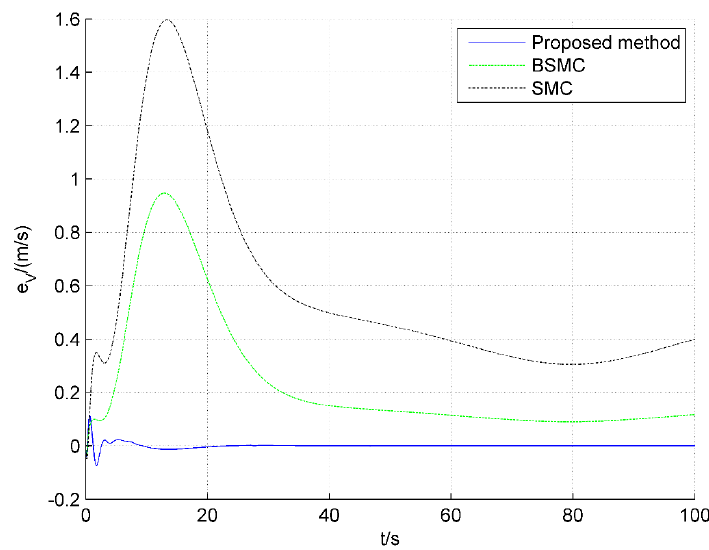
Figure 5. Tracking errors of velocity.